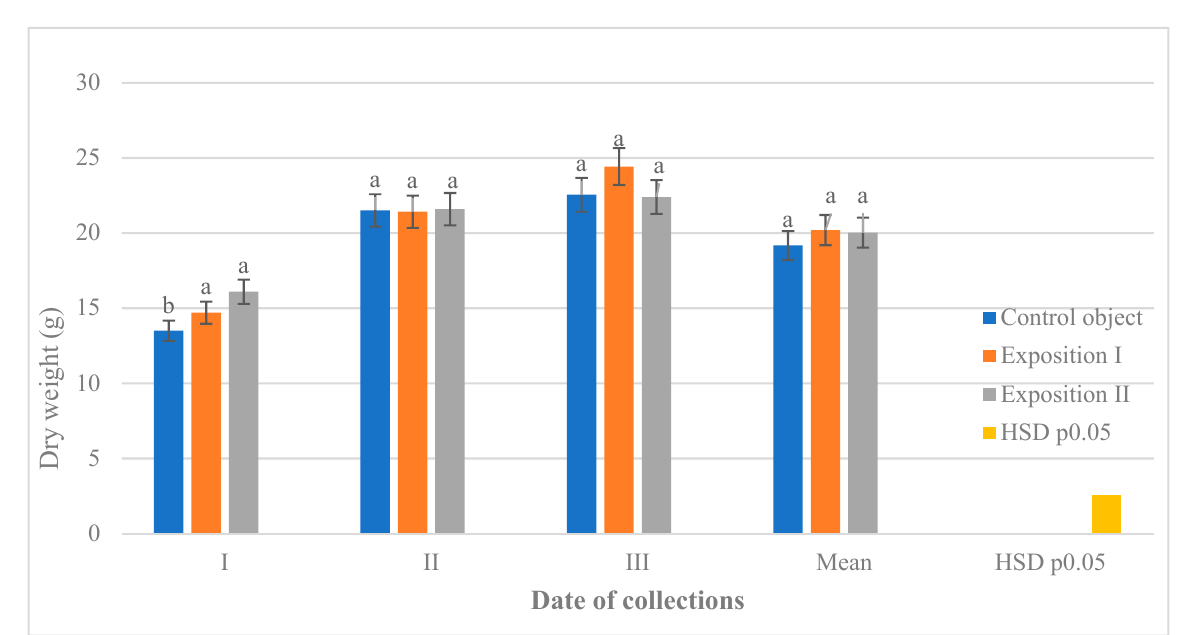
Figure 8. The effect of stimulation of seeds and time collection on the dry weight of leaves (2015–2017). I—20 days after sowing, II—40 days after sowing, and III—60 days after sowing; control object—the seeds without stimulation with FM, exposition I—the seeds were stimulated with FM for 15 s, and exposition II—the seeds were stimulated with FM for 30 s.; Letter indicators (a, b, c, etc.) next to averages refer to the so-called homogeneous (statistically homogeneous) groups. The occurrence of the same letter indicator next to the means (at least one) means that there are no statistically significant differences at p 0.05 between them.